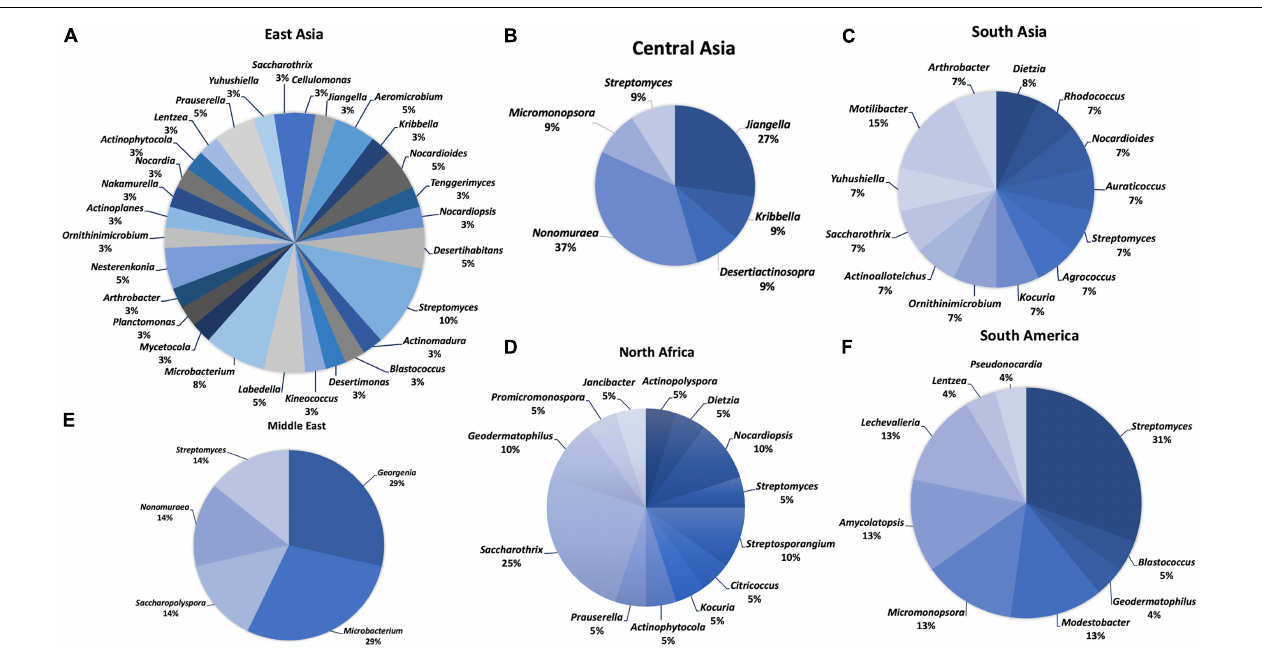
FIGURE 2 | Distribution of desert actinobacteria from different geographical regions: (A) East Asia, (B) Central Asia, (C) South Asia, (D) North Africa, (E) Middle East, and (F) South America.